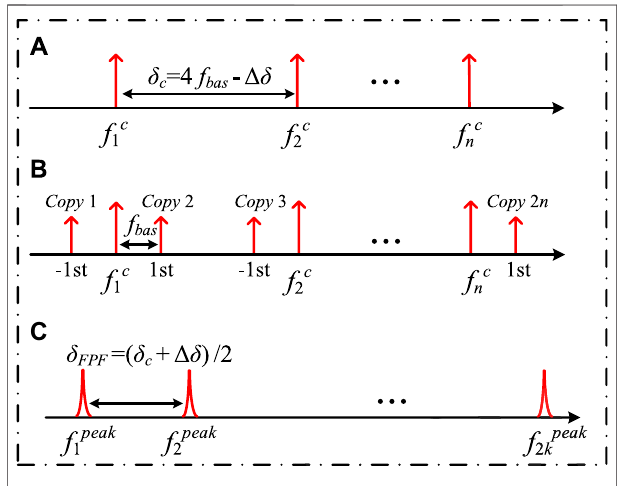
FIGURE 2 | Spectra diagrams of (A) the selected optical comb lines, (B) modulated optical comb lines after double sideband modulation, and (C) transmission peaks of the Fabry-Perot fi